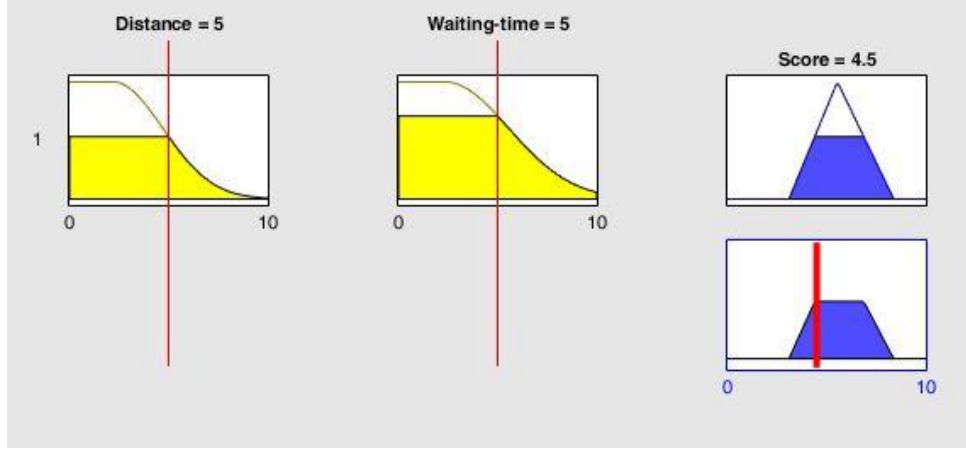
Figure 3. Membership functions and rule of fuzzy model for the charging infrastructure (CI) score.